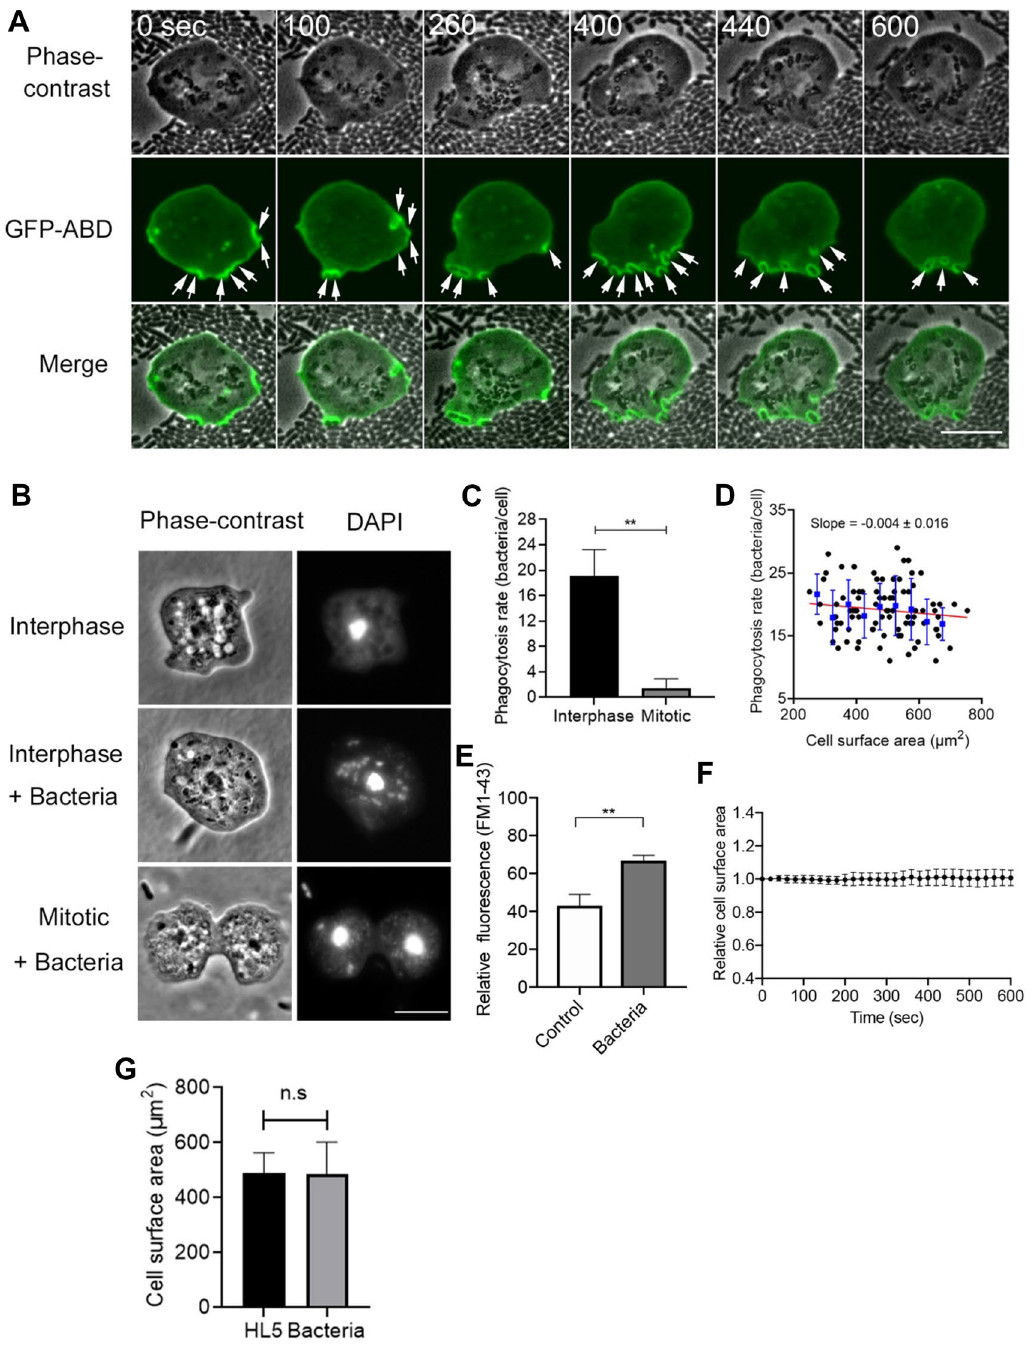
Figure 3. The cell surface area is maintained by a dynamic balance between exocytosis and endocytosis. ( A ) Representative time courses of phase-contrast, fluorescence, and merge images of a live cell expressing GFP- ABD in the presence of bacteria. Arrows indicate bacteria being internalized by the cells. Scale bar, 10 µm. ( B ) Representative phase-contrast and fluorescence images of cells stained with DAPI in the presence and absence of bacteria. Many bacteria were found in interphase cells, but a few bacteria were found in mitotic cells. Scale bar, 10 μm. ( C ) The number of bacteria within interphase and mitotic cells. Data are presented as the mean ± SD. **P < 0.001; n ≥ 80 for each. ( D ) The phagocytosis rate for 10 min versus the cell surface area at birth. The blue vertical lines show the binned mean ± SD. Linear regression lines are shown in red (n = 87). ( E ) Quantitative analysis of the membrane uptake in the presence and absence of bacteria (for 10 min). Cells were stained with FM1-43 and measured using fluorescence spectrophotometry in each condition. Data are presented as the mean ± SD. **P < 0.001, three different experiments. ( F ) A time course of the total cell surface area in the presence of bacteria (n = 28). ( G ) The total surface area in the presence and absence of bacteria. Data are presented as the mean ± SD (n ≥ 87 for each). ns, not